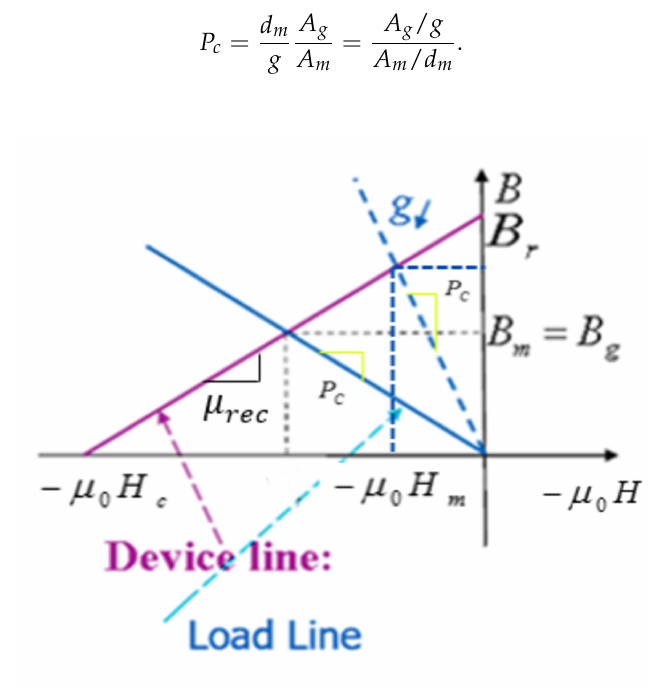
Figure 6. B - H curve of a permanent magnet